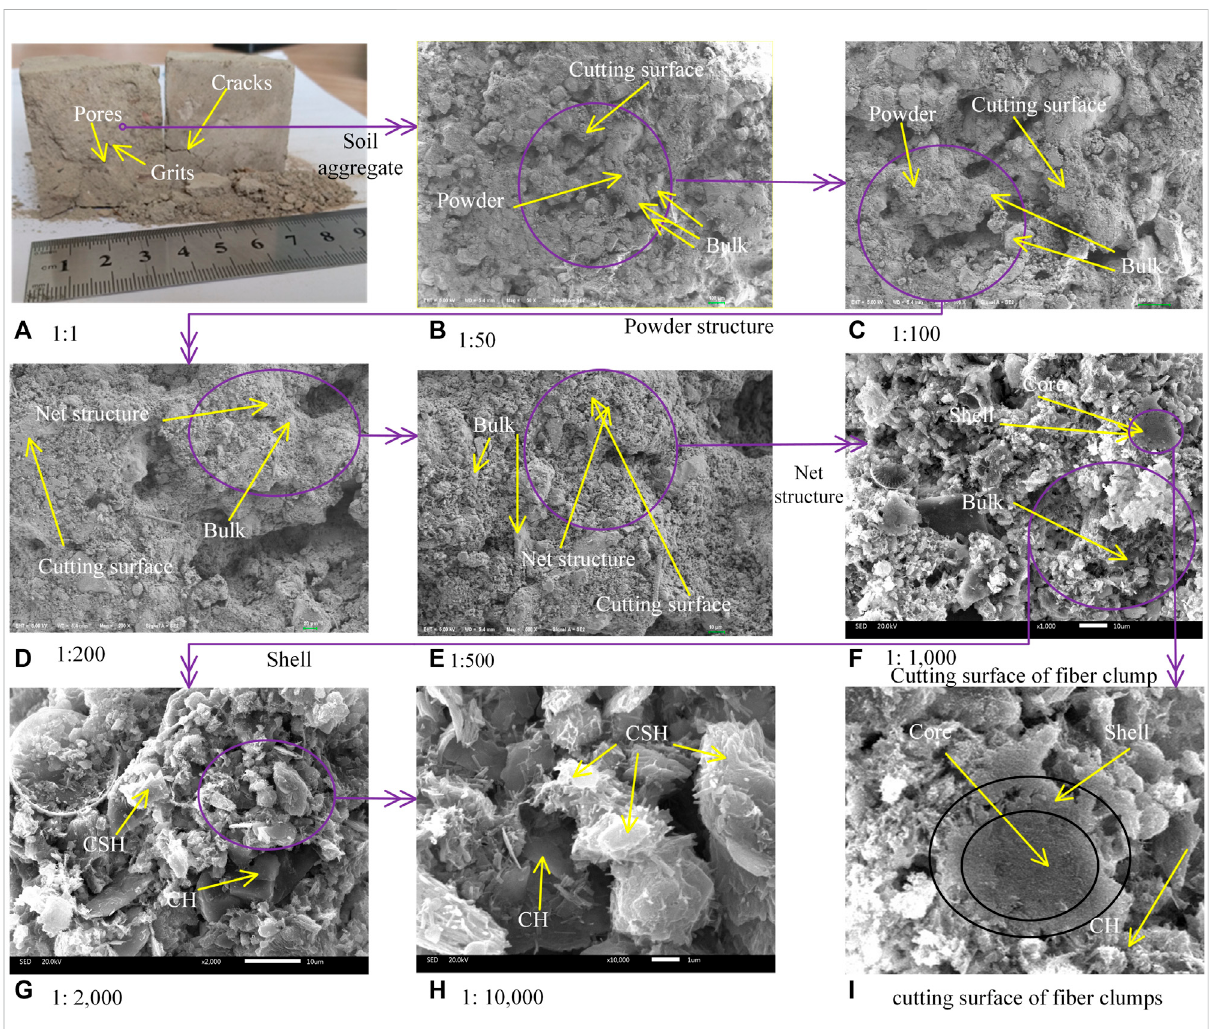
FIGURE 6 Microstructures of S/S sediments at different scales: (A) 1:1, (B) 1:50, (C) 1:100, (D) 1:200, (E) 1:500, (F) 1:1,000, (G) 1:2,000, and (H) 1:10,000. (I) Cutting surface of fi ber